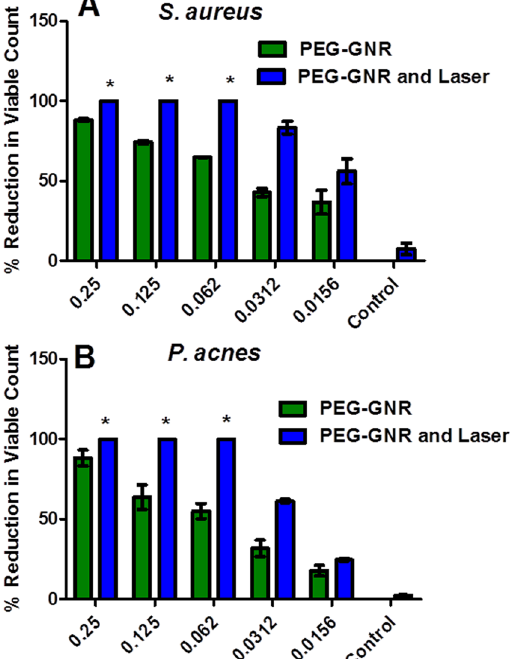
Figure 6. Percentage reduction of bacterial viable count of ( A) S . aureus and ( B) P . acnes pre-treated with PEG- GNR alone compared to those treated with PEG-GNR followed by laser beam exposure. * Percentage reduction of bacterial viable count ≥ 99.99%, i.e. ≥ 4 log 10 cycles. The standard deviations for the first three bars are very